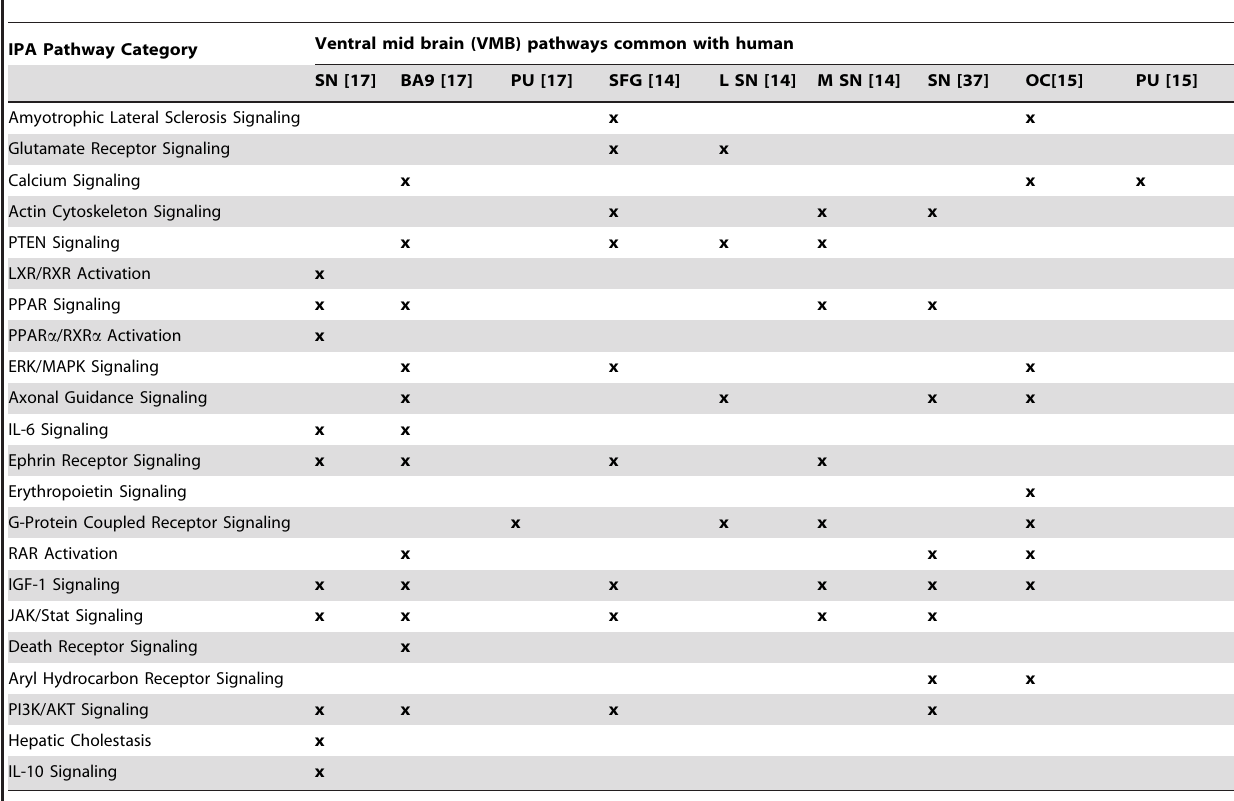
Table 2. Overlapping signaling pathways between human PD transcriptome studies and signaling pathways in VMB of PQ, PY and MNPQ mouse models of PD.